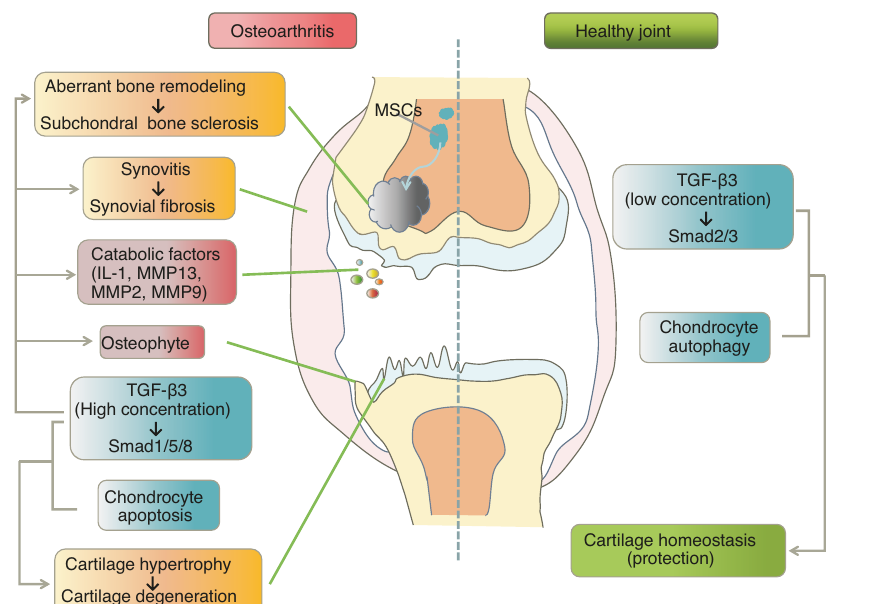
Fig. 5 Schematic diagram showing the role of transforming growth factor-beta 3 (TGF- β 3) in osteoarthritic and healthy joints. In healthy articular cartilage, low concentrations of TGF- β 3 promote metabolic balance through the Smad2/3 pathway. Chondrocyte autophagy also plays a protective role. TGF- β 3 is also involved in many aspects of osteoarthritis (OA) pathology mediated through the Smad1/5/8 pathway. High concentrations of TGF- β 3 in osteoarthritic joints induce the production of catabolic factors and chondrocyte hypertrophy, ultimately resulting in cartilage matrix degradation, osteophyte formation, and synovial fi brosis. In addition, high levels of TGF- β 3 upregulate the expression of Runt-related transcription factor 2 (Runx2) via the Smad1/5/8 pathway, leading to aberrant bone remodeling and further subchondral bone sclerosis. In addition, chondrocyte switching from autophagy to apoptosis has been implicated in OA progression. IL-1 interleukin-1, MMP13 matrix metalloproteinase 13, MMP2 matrix metalloproteinase 2, MMP9 matrix metalloproteinase